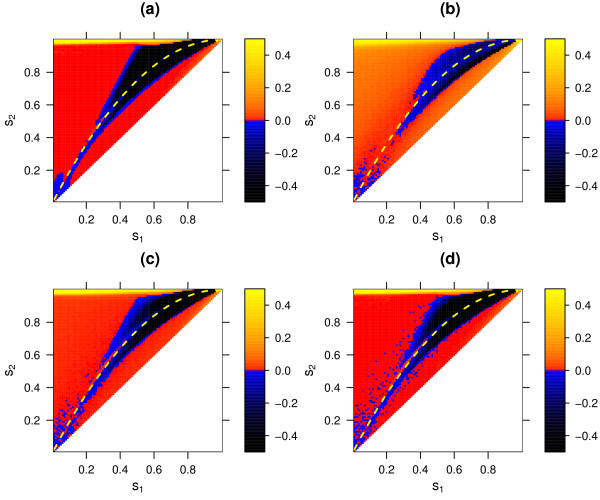
Selective advantage of a modifier increasing the recombination rate in the sequential-updating model (rmm = 0.1, rmM = 0.15, rMM = 0.2), for the deterministic regime (a) and for the stochastic regime with population size N = 1000 (b), N = 10 000 (c), and N = 100 000 (d). For further details see legend of figure 5.